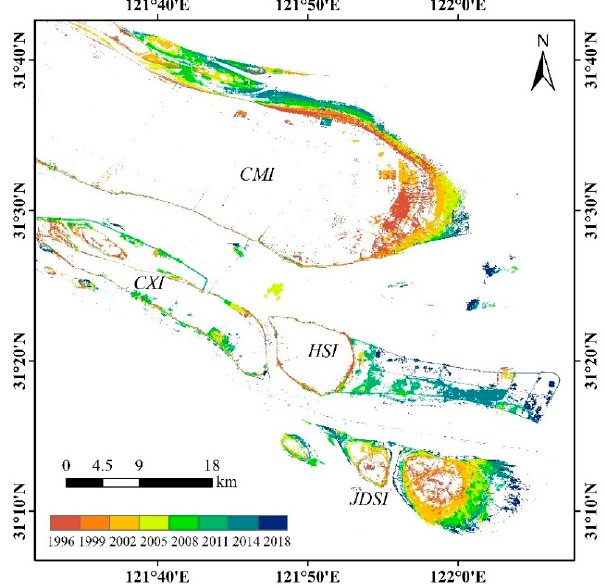
Figure 6. Dynamic of tidal flats in YRE from 1996 to 2018, shown for every 4 years, except for 2018.